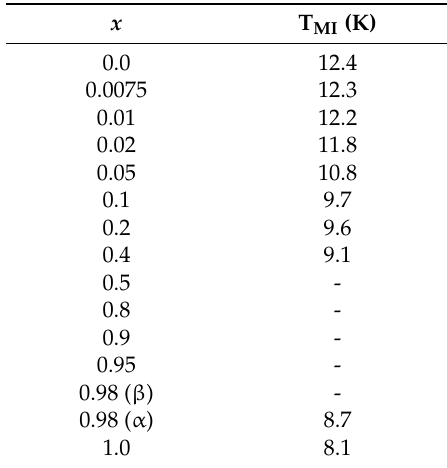
Figure 4. Electrical transport properties of (Per) 2 [Pt x ‐ Au (1 − x ) (mnt) 2 ] single crystals with composition values indicated as a function of temperature, T: ( a ) Electrical resistivity, R, plotted as ratio to the room temperature (Rrt) value; ( b ) Absolute thermoelectric power (values for increasing x are off ‐ set by 5 μ V/K at room temperature for each composition). Table 2. Metal ‐ to ‐ insulator transition temperatures, T MI , of (Per) 2 [Pt x Au 1 − x (mnt) 2 ] crystals as defined by maxima in the derivative of the resistivity, dln ρ /d(1/T).